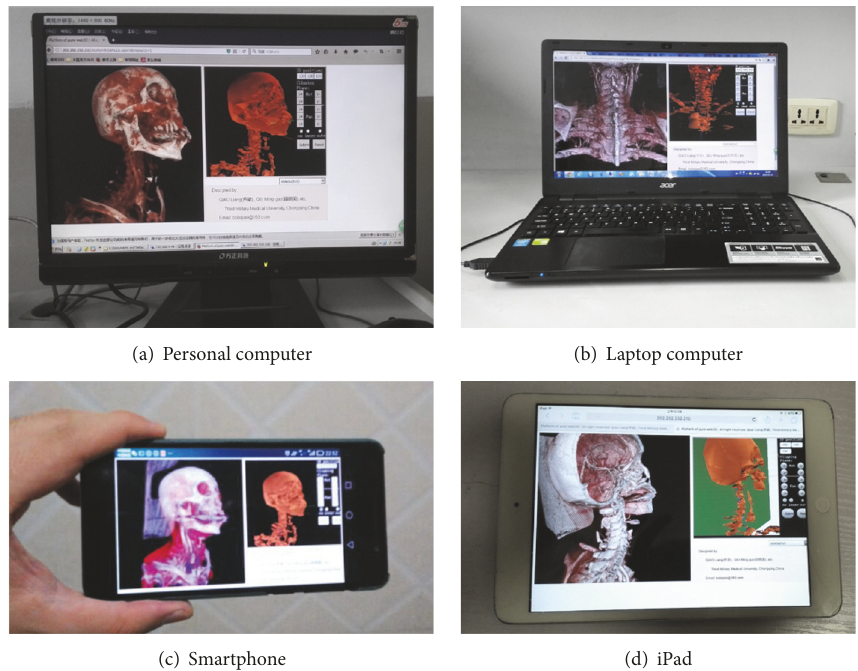
Figure 7: The system is accessed via four different devices and web browsers under extreme